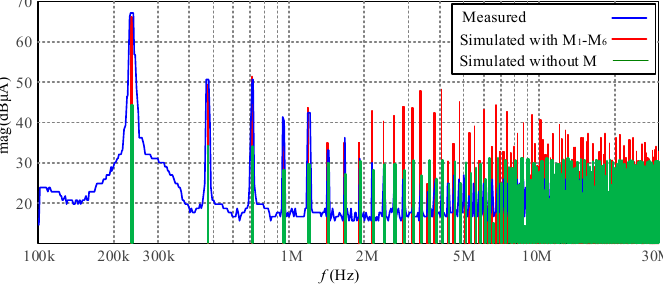
Figure 9. Simulated and measured CM conducted